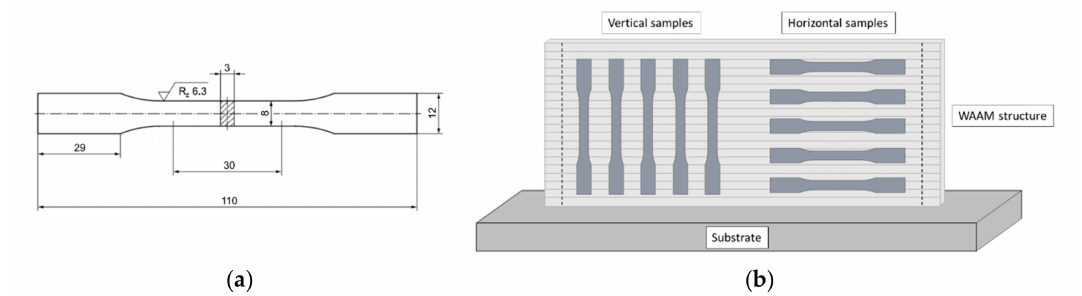
Figure 2. Dimensions of tensile sample in mm, R z in µ m ( a ) and schematic representation of sample extraction ( b ).